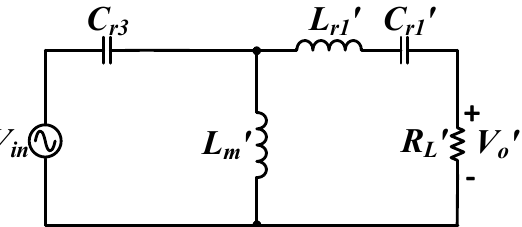
Figure 6. Equivalent circuit of a 2C2L resonant circuit in reverse energy charging mode.